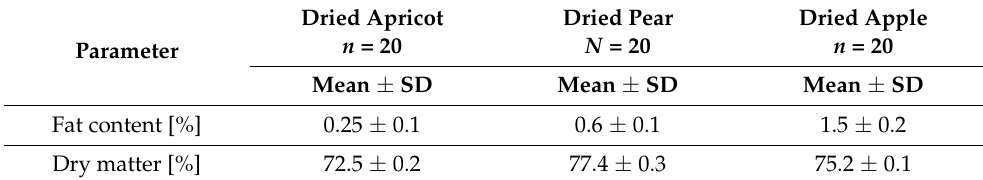
Table 1. Fat content and dry matter in dried fruit.